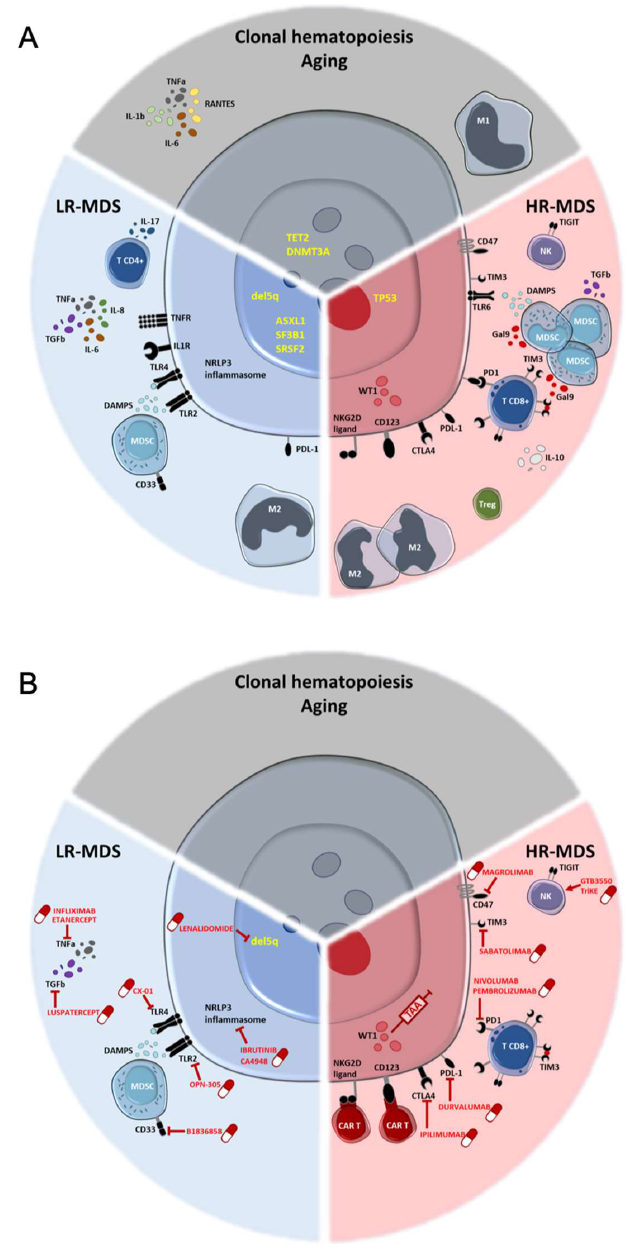
Figure 1. From immune dysregulations to therapeutic perspectives in myelodysplastic syndromes. ( A ) Immune key hubs involved in early stages, low-risk MDS, and high-risk MDS. ( B ) Available and potential drugs targeting immune system in MDS. CD: Cluster of Differentiation; CTLA-4: Cytotoxic